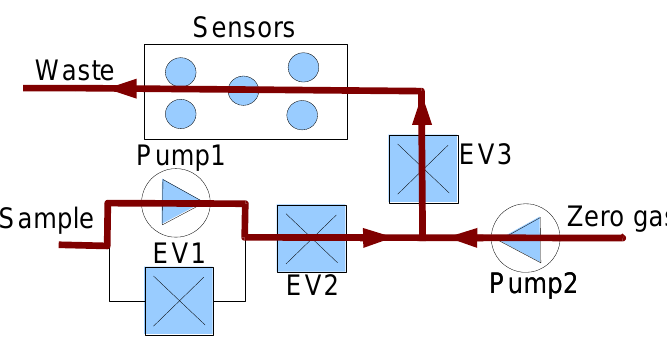
Figure 3. Gases flow at the injection stage.